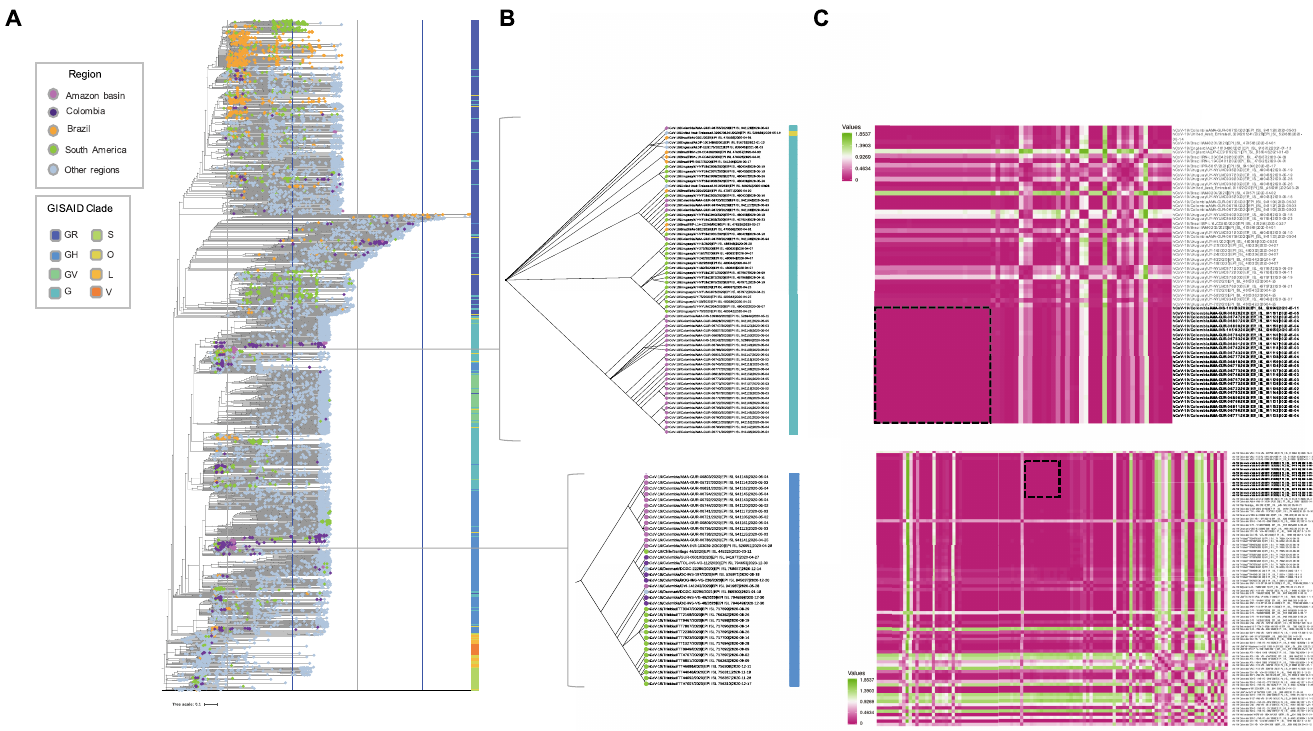
Fig 2. SARS-CoV-2 clusters in the Colombian Amazonas department. A. Maximum Likelihood tree built of 9,712 genomes used in this study and worldwide diversity. The colors of the tips indicate the geographical origin of the genomes highlighting the Amazonas department, Colombia, Brazil and South America genomes in specific colors. The colors of the bar on the right indicate the GISAID clade assignment. B. Magnification of the two clusters, C1 and C2; isolates colored by region and GISAID clade. C. Heatmap visualization of the distance matrix of the clade which include the cluster C1 (up) and the clade which include the cluster C2 (down), the clusters identified in our study are the largest group of Amazonas genomes with the lowest dissimilarity value, C1 and C2, represented by dotted lines within each heatmap.